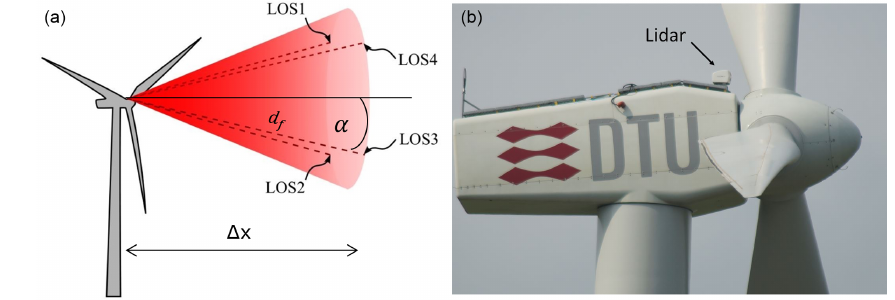
Figure 4. (a) Illustration of the four-beam lidar focus locations on a cone with apex at the turbine nacelle. (b) Photo of the four-beam lidar mounted on the Vestas V52 turbine at the Risø test site. Table 1. Information of lidar setup parameters and measurement periods. The azimuth angle refers to the position on the scanning cone surface with 0 ◦ being the top of the cone.